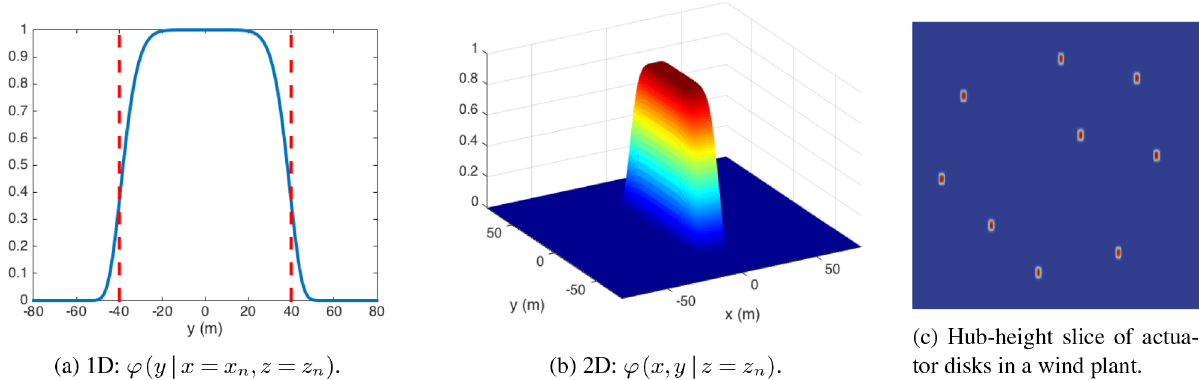
Figure 1. A continuously differentiable modified exponential distribution is used to smoothly distribute the turbine forces and power pro- duction over the rotor swept area. The smoothing function is demonstrated for an 80m rotor diameter turbine with γ = 6 for 1-D and 2-D prototypes in panels (a) and (b) by taking conditional distributions of ϕ ( x,y,z ) in Eq. (12). The edge of the rotor disk is represented by vertical dashed red lines in panel (a) . Panel (c) is a hub-height slice showing how a wind plant is represented as a summation of smoothed actuator disks.